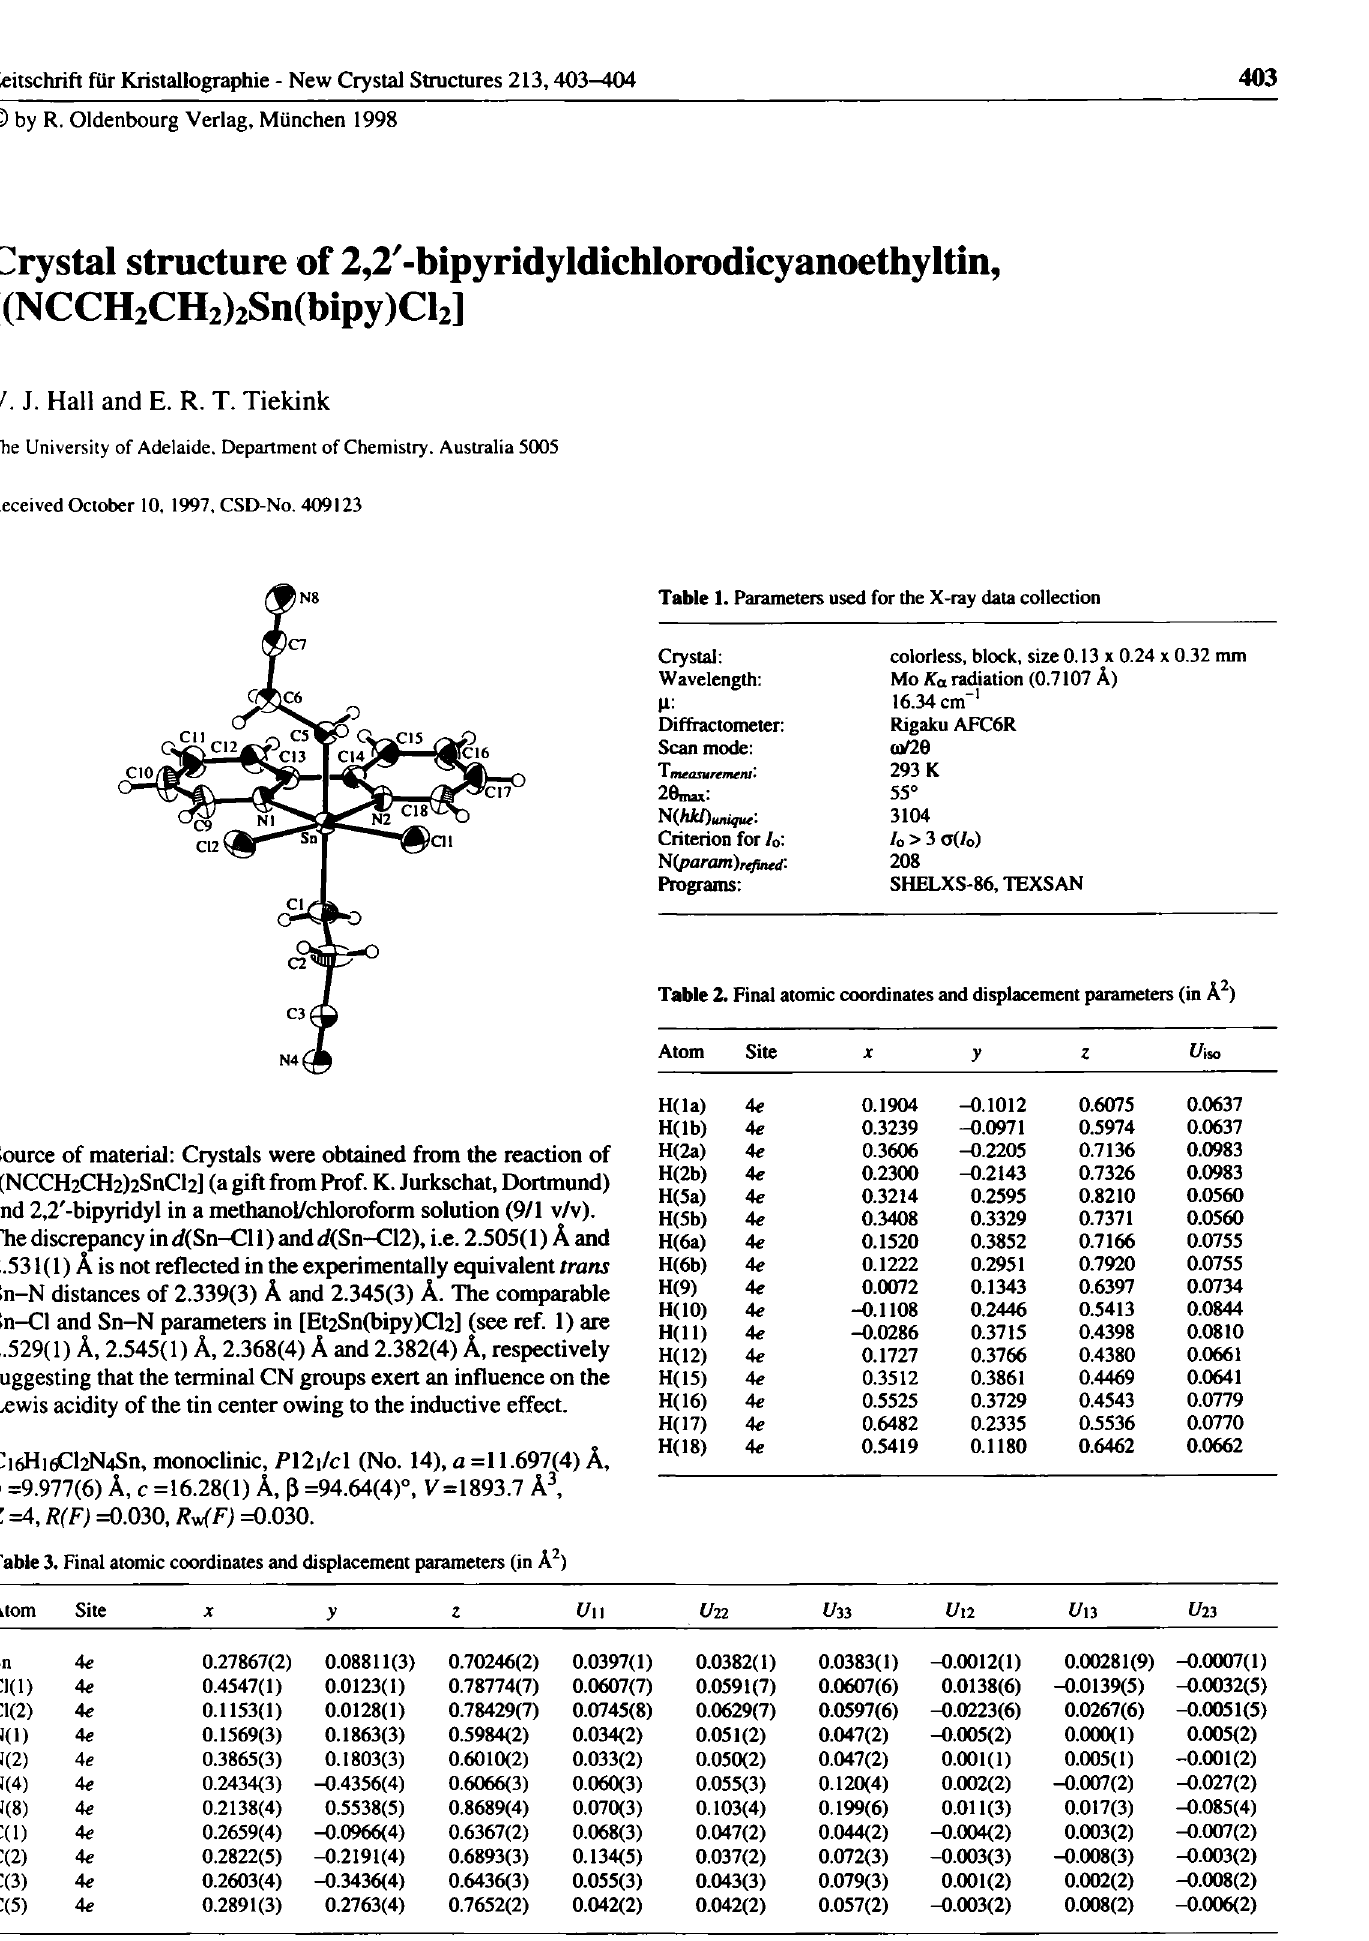
Table 1. Parameters used for the X-ray data collection